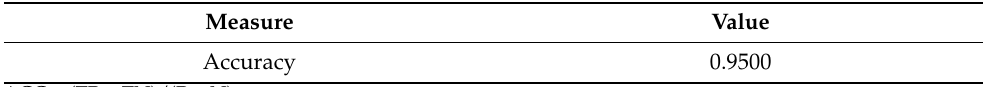
Table 3. The accuracy of the